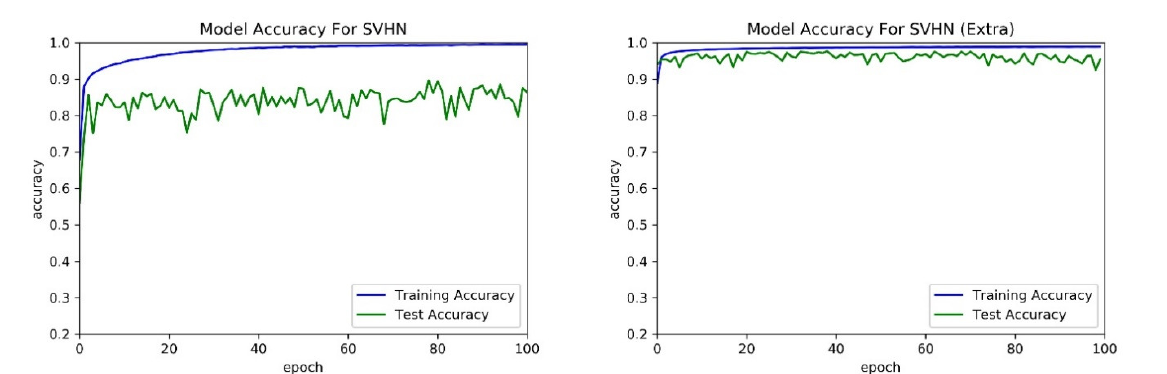
FIG. 7: ACCURACY OF SVHN AND SVHN (EXTRA) DATA SETS